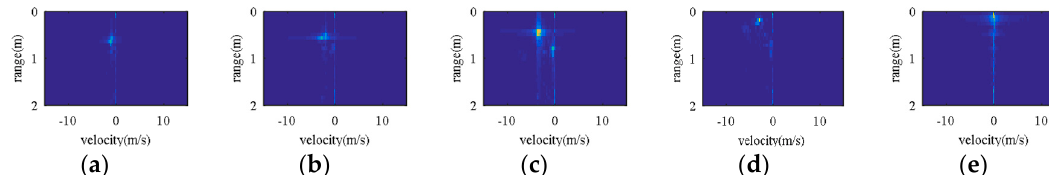
Figure 11. Traditional RDMs without windowing and IF-BPF of a push hand gesture. ( a ) Traditional RDM of frame 1. ( b ) Traditional RDM of frame 7. ( c ) Traditional RDM of frame 12. ( d ) Traditional RDM of frame 22. ( e ) Traditional RDM of frame 28.